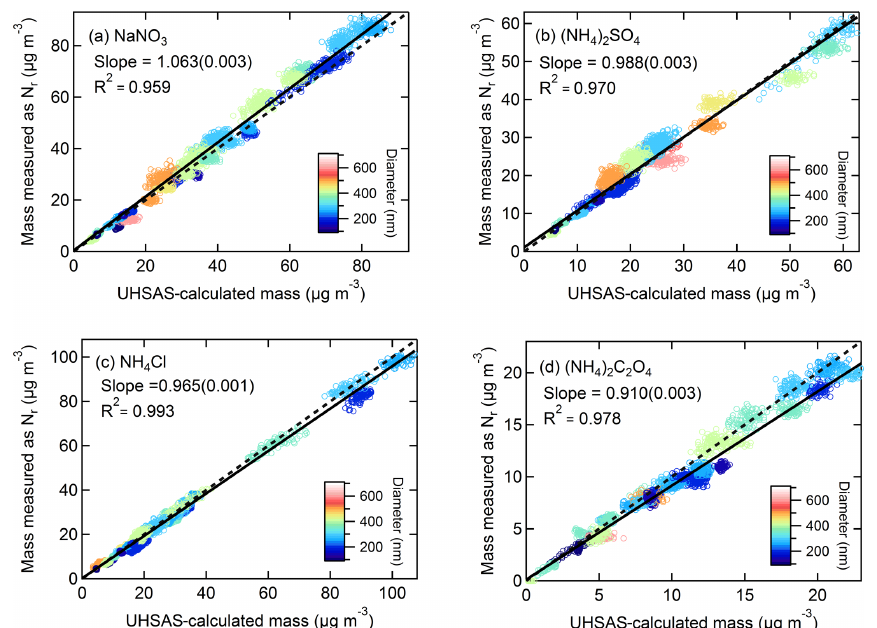
Figure 5. Correlation plots of mass concentrations measured as N r for (a) NaNO 3 , (b) ( NH 4 ) 2 SO 4 , (c) NH 4 Cl, and (d) ( NH 4 ) 2 C 2 O 4 versus mass concentrations calculated using CPC number concentrations with UHSAS size distributions. Particle sizes (nm) are indicated by the color plot and the 1:1 line is shown in dashed black. The solid lines are orthogonal distance regression fits. The slope (uncertainty) and R 2 is shown.